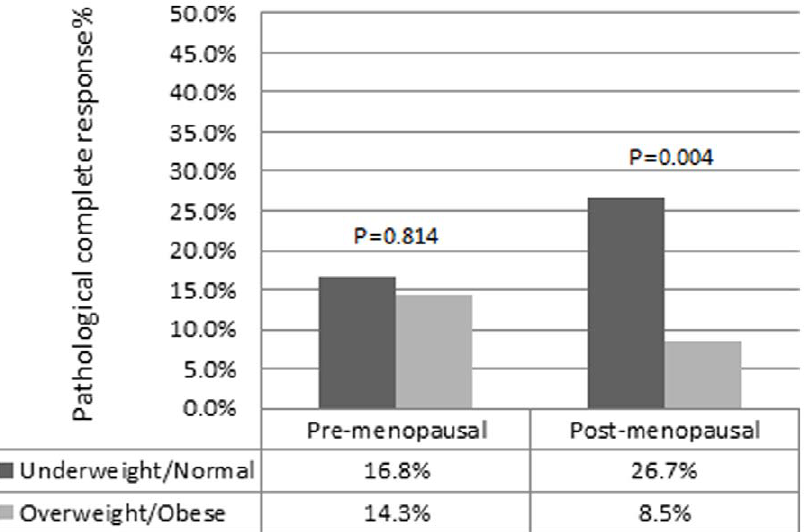
Figure 3. Probability of pathological complete response according to menopausal status and BMI category.